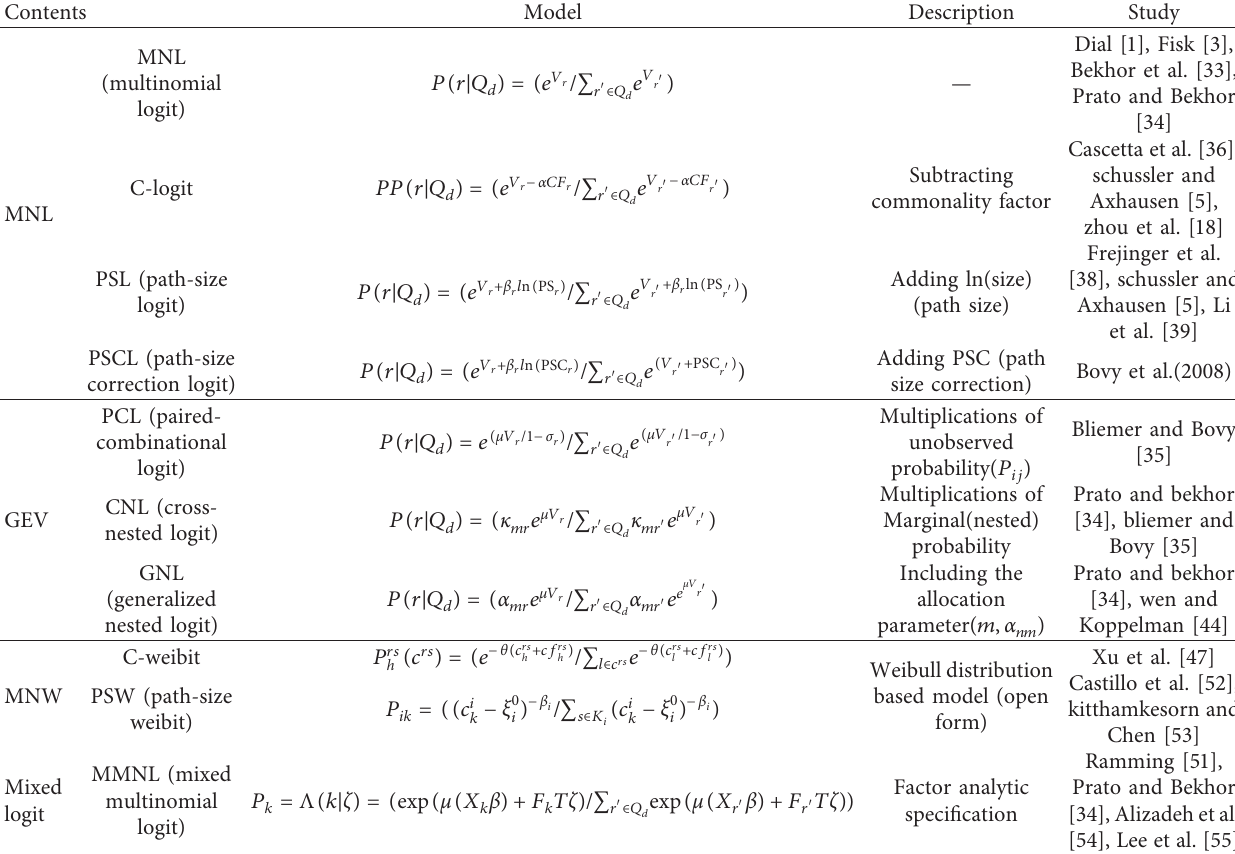
Table 1: Summary of route choice